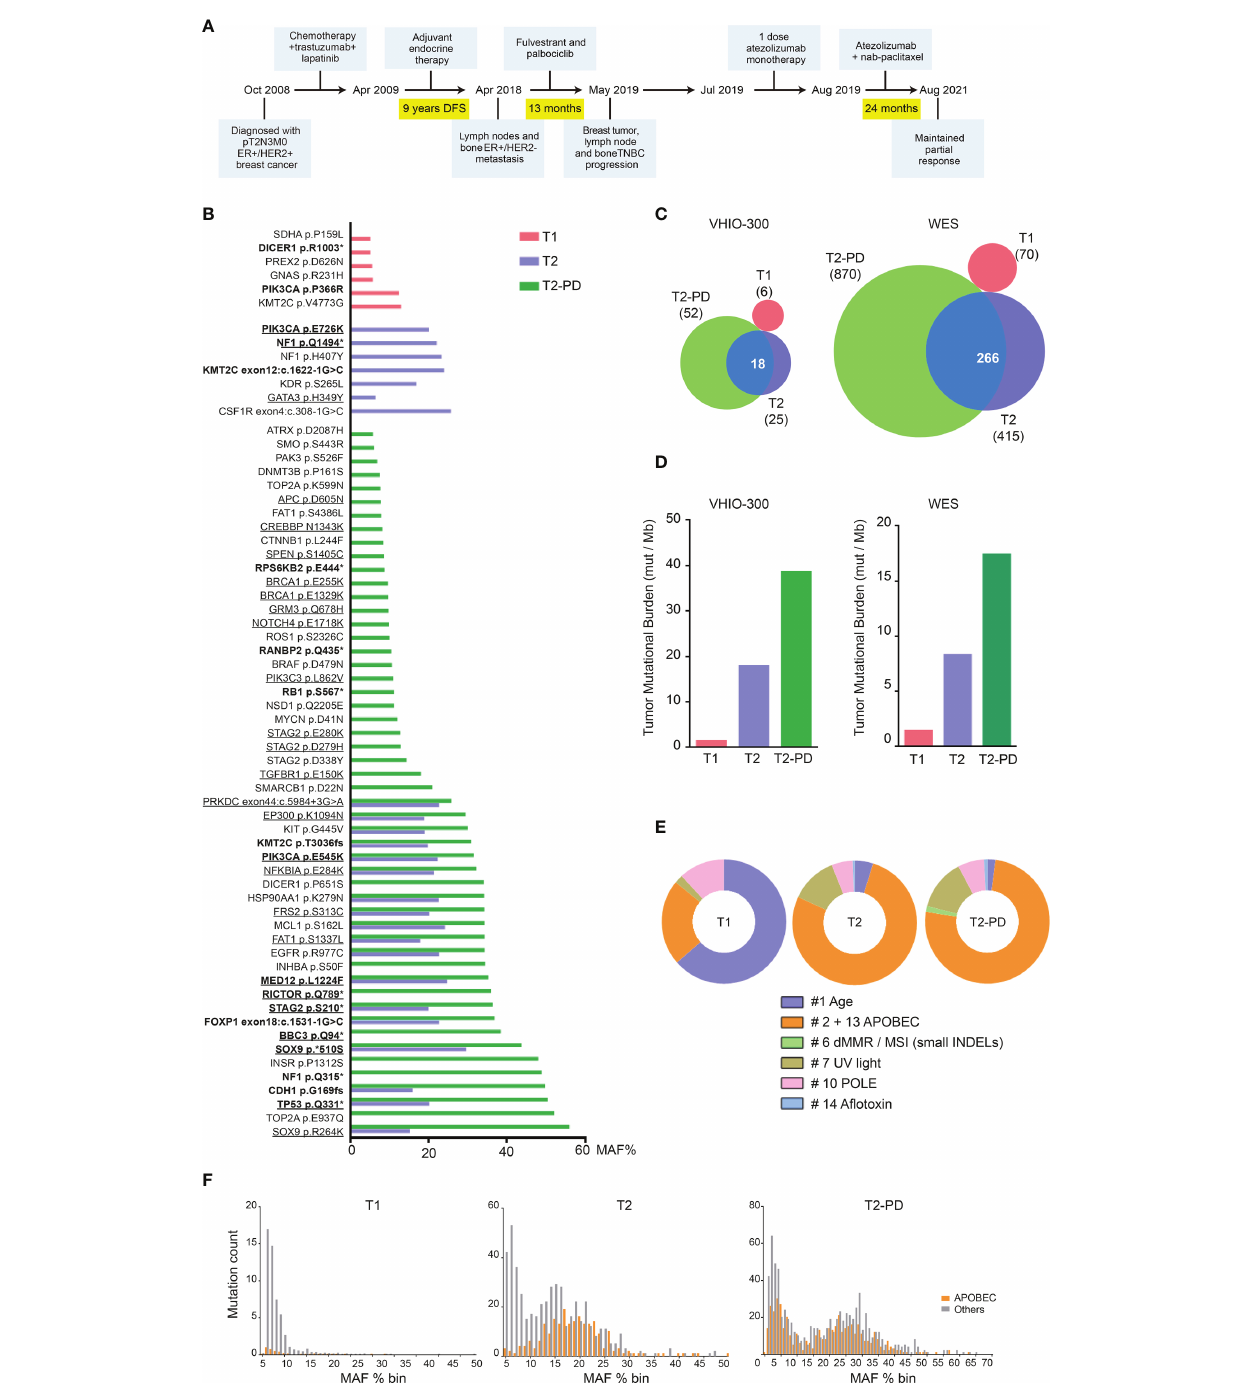
FIGURE 1 | Patient treatment timeline and DNA alterations. (A) Patient treatment timeline. (B) Mutant Allelic Frequency (MAF; %) in T1 (sample of 2008), T2 (sample of 2018), and T2-PD (sample of 2019) determined using the VHIO-300 panel. Variants classi fi ed as pathogenic or likely pathogenic are highlighted in bold; variants matching APOBEC DNA-sequence signature are underlined. (C) Overlap of somatic mutations between T1, T2, and T2-PD using the VHIO-300 panel and whole-exome sequencing (WES). (D) TMB expressed as mutations/megabase in T1, T2, and T2-PD using the VHIO-300 panel and WES. (E) COSMIC mutational signatures of age, APOBEC defect (APOBEC), defective mismatch repair/microsatellite instability (dMMR/MSI) re fl ected as small insertions and deletions (INDELs), ultraviolet light (UV), polymerase E defect (POLE), and a fl otoxin effect in T1, T2, and T2-PD determined by WES. (F) MAF distribution for APOBEC-related and other mutations in T1, T2, and T2-PD determined by